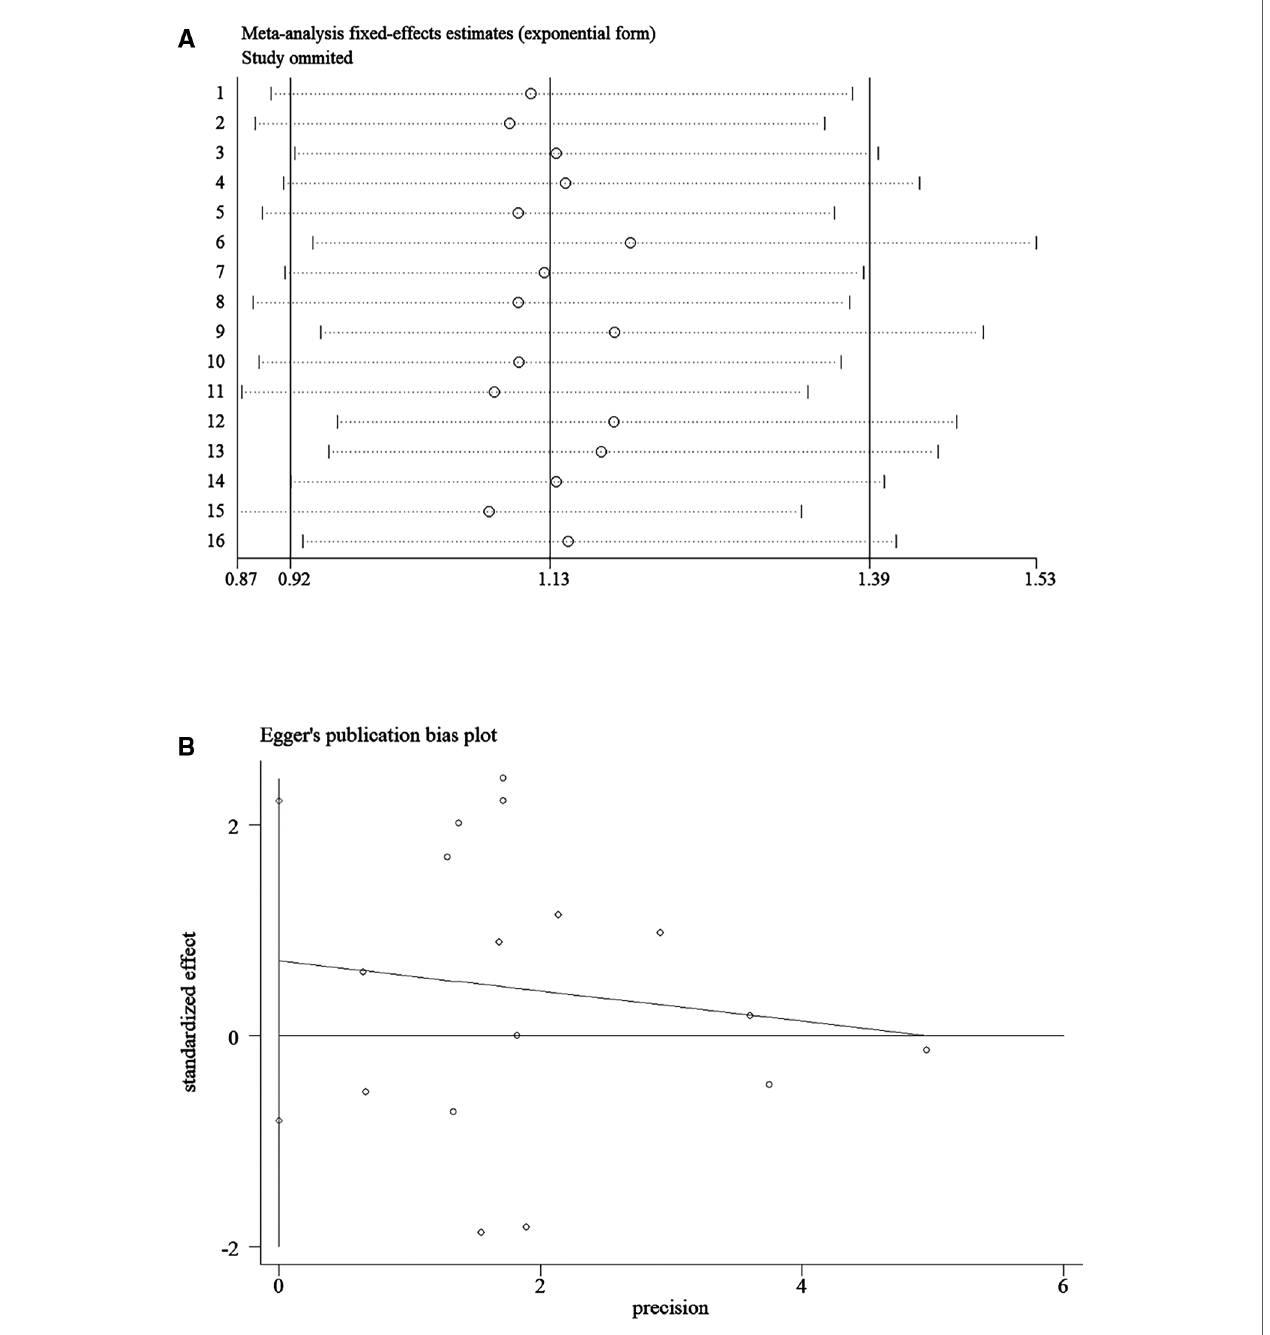
FIGURE 2 Sensitivity analysis and Egger ’ s publication bias plot of the incidence of intra-abdominal abscess, ( A ) sensitivity analysis; ( B ) Egger ’ s publication bias